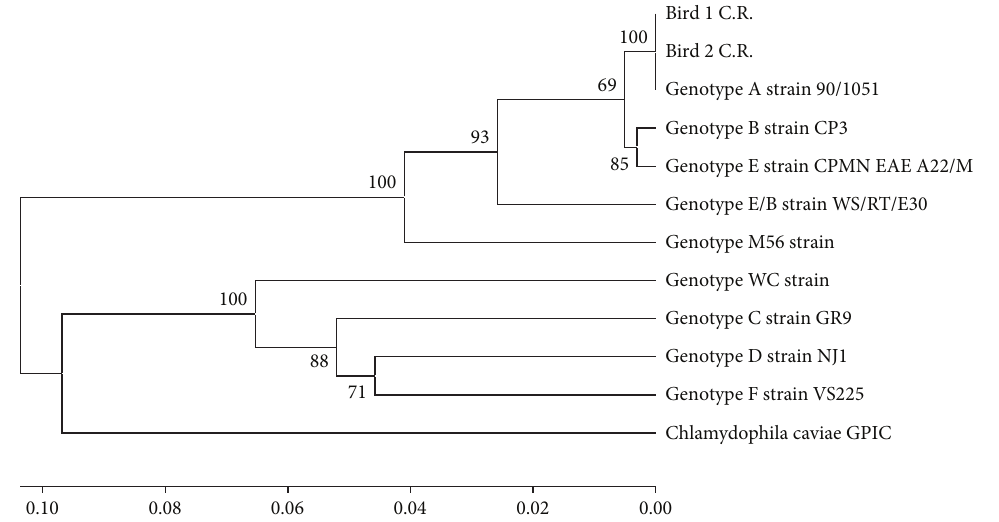
Figure 2: Phylogenetic tree of gene ompA sequence of two samples of psittacines (Bird 1 C.R. and Bird 2 C.R.) of Costa Rica positive to C. psittaci